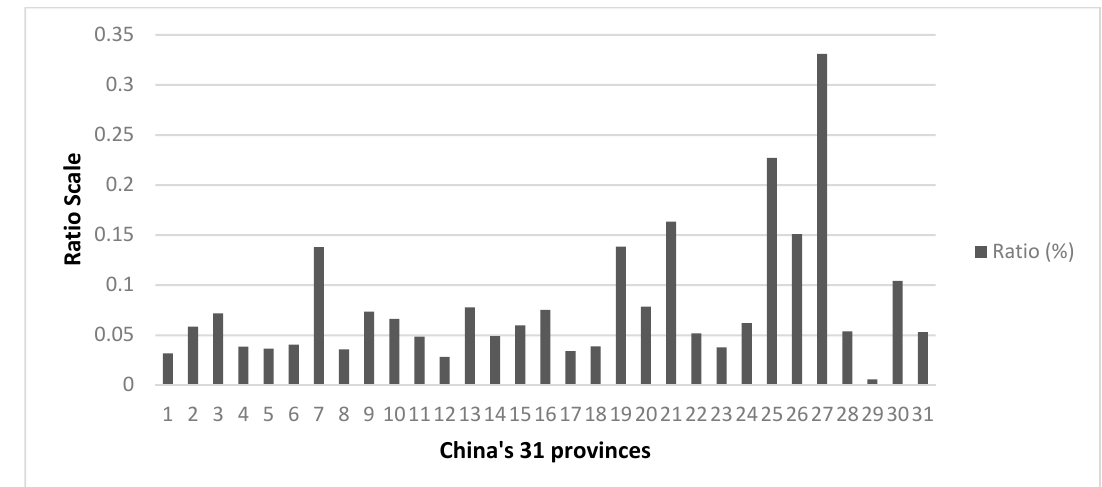
Figure 3. The Ratio of the Number of Patients served by Community-based Healthcare Centers to Patients Served by Tertiary Hospitals across 31 Provinces. Source: China Health Statistics Yearbook (2016); Note: The sequence of the 31 provinces is the same as the province list in Table 5; Xinjiang Production and Construction Corps (XPCC) is excluded here since its data is not recorded as a province in the yearbook.